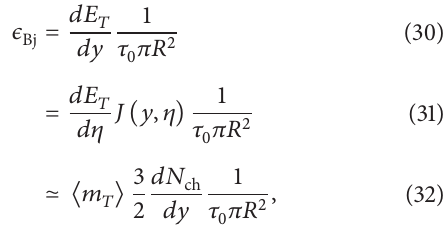
Figure 40: The Bjorken energy density versus 𝑁 estimates of the transverse overlap area at √𝑠 figure is taken from